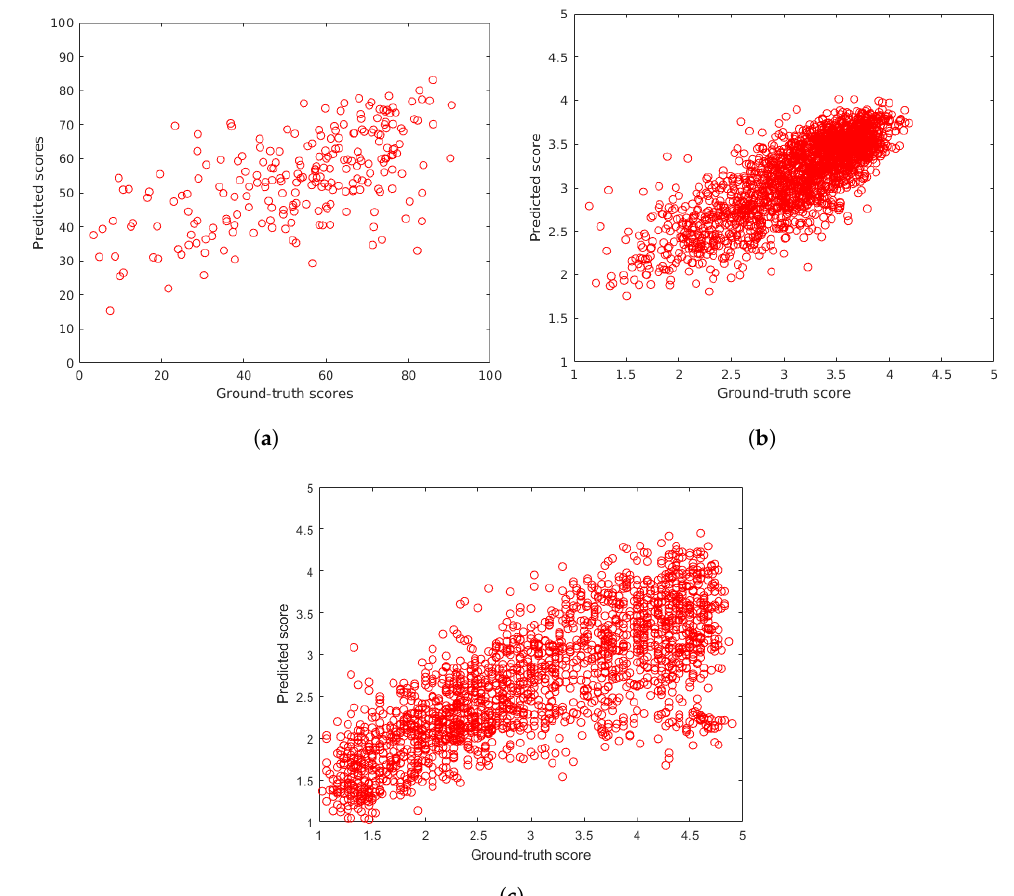
Figure 9. Ground-truth scores versus predicted scores using the proposed LFD-IQA-GPR method on